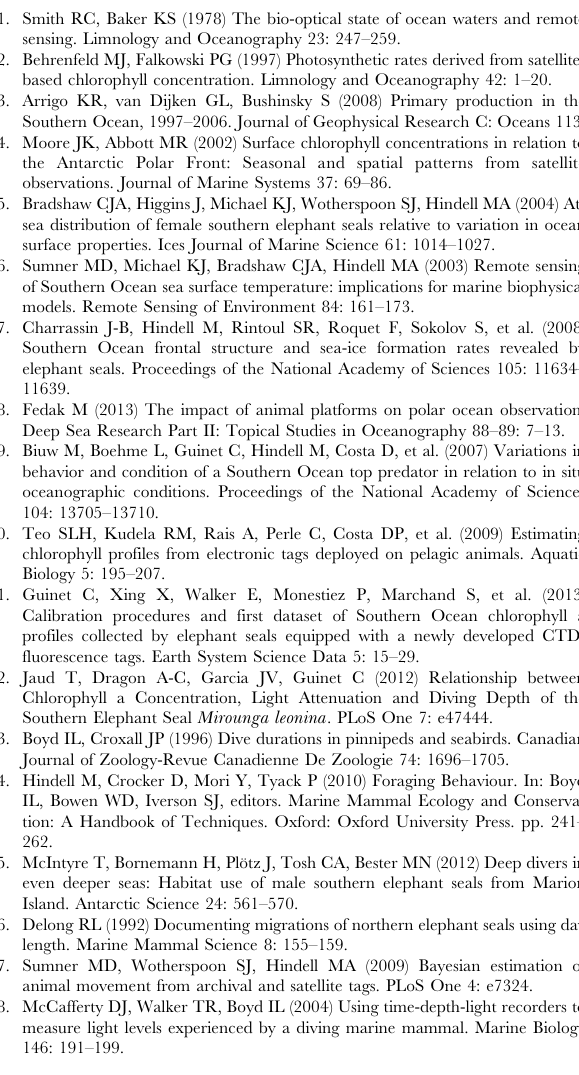
and the coast of East Antarctica and Ross Sea (bottom). The black asterisks show Macquarie Island (MI). (TIF) Table S1 Ranked mixed models at 1 6 resolution. Satellite-derived chlorophyll ( chl-a ) explained by integrated light attenuation above 250 m (LA 250 ), season, latitude and frontal zone (FZ) ( n = 67 seals) { . Mixed models are ranked by decreasing Akaike’s Information Criterion (AIC) and change in AIC ( D AIC) [41]; the most parsimonious model having the lowest AIC.